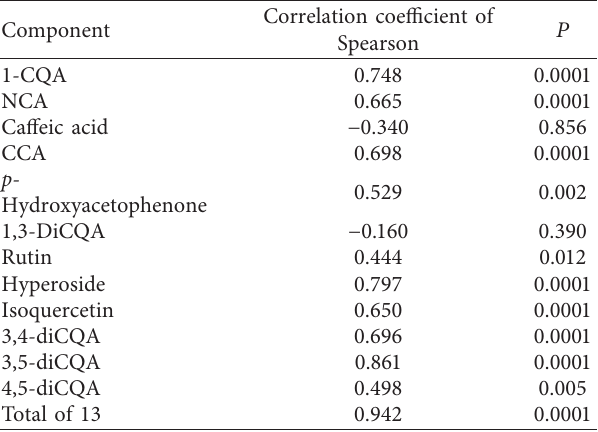
Figure 6: The bar graph of contents of 13 components in 31 batches of A. capillaris . Table 6: Bivariate correlation analysis results of the correlation between the contents of CA and 12 other components and the total of all 13 components in 31 batches of A. capillaris